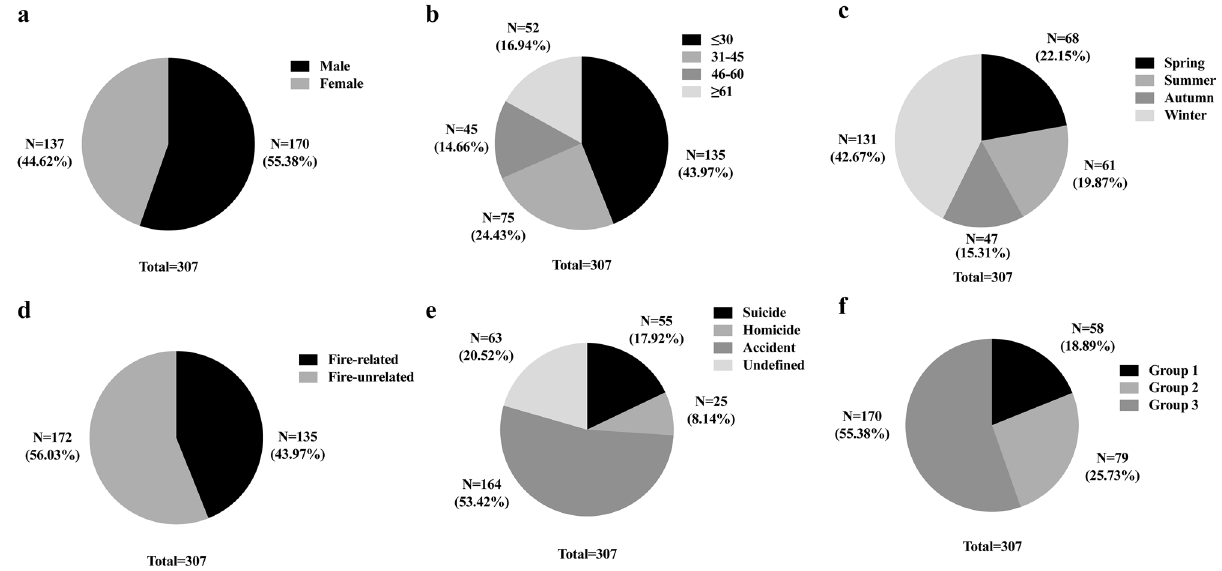
Figure 2. Distribution of the CO poisoning deaths by gender ( a ), age ( b ), season ( c ), fire-circumstance ( d ), manner of death ( e ), and heart blood COHb% ( f ). Group 1: 10 < COHb < 30% (n = 58); group 2,